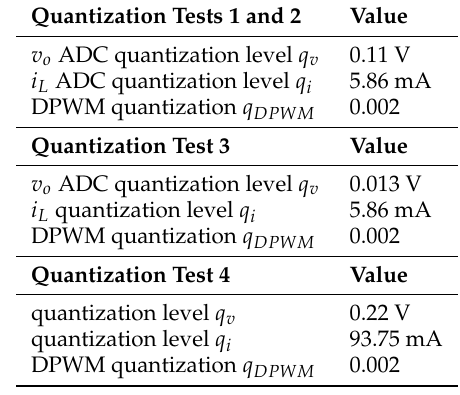
Table 3. ADC quantization parameters controller design.